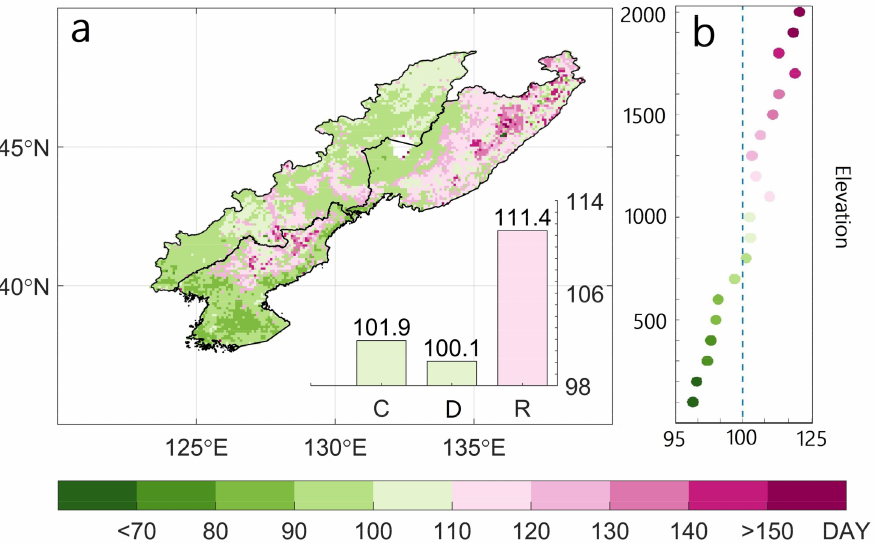
Figure 2. ( a ) Spatial distribution of multi-year mean value of SOS in the China (C), DPRK (D) and Russia (R) cross-border from 1982 to 2015; ( b ) Distribution of SOS along the elevation in the China–DPRK–Russia cross-border